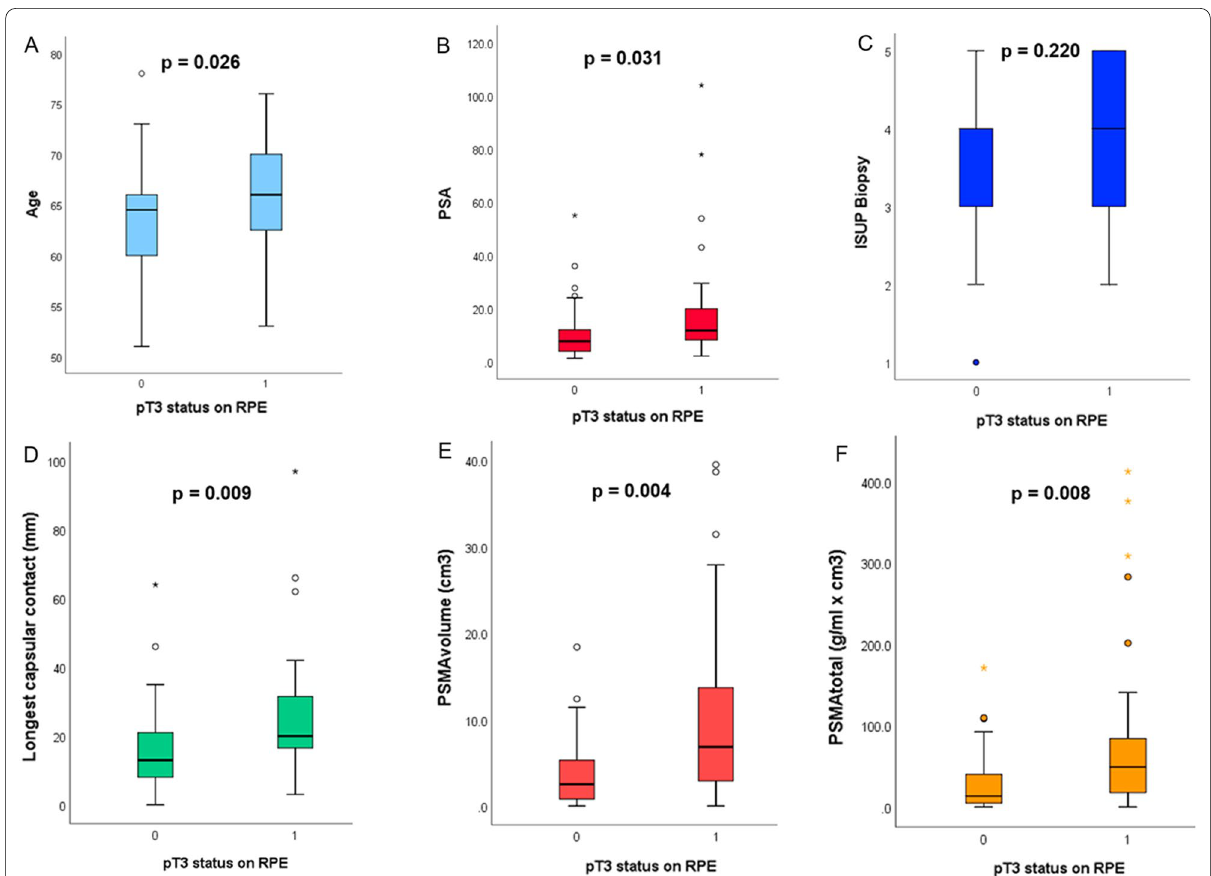
Fig. 2 Box plots illustrating the relationship between pT3 status and ( a ) age, ( b ) PSA, ( c ) ISUP biopsy, ( d ) longest capsular contact, ( e ) PSMA volume , and ( f ) PSMA total